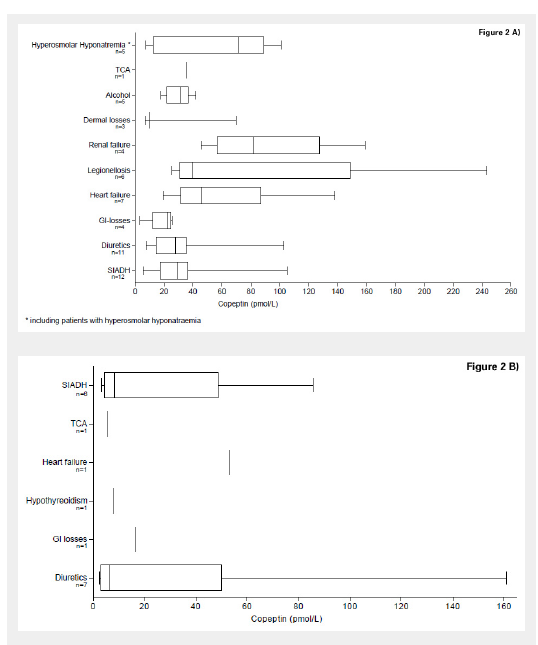
Figure 2 A) Copeptin levels in the differential diagnosis of hypoosmolar and hyperosmolar hyponatraemia (Study A/B) B) Copeptin levels in the differential diagnosis of hypoosmolar hyponatraemia (Study